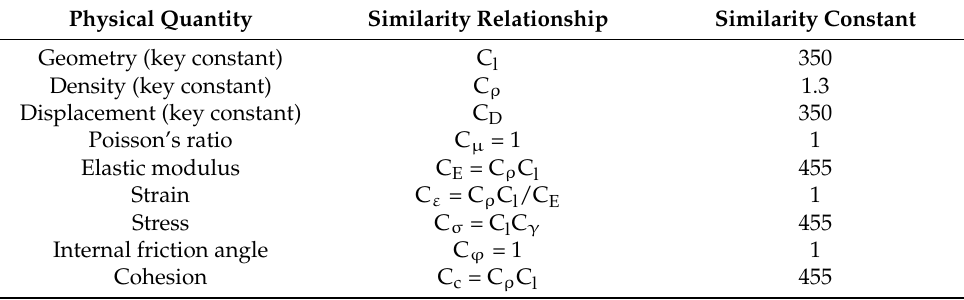
Table 2. Physical and mechanical parameters of the rock and rock mass.